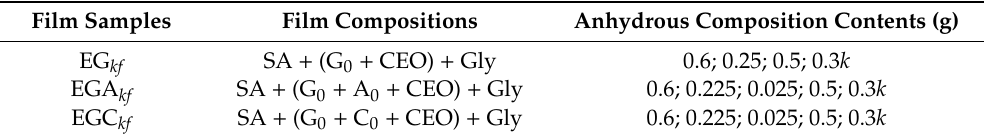
Table 1; secondly, after the films G, GA, and GC were obtained, each film was immersed in 25 mL of 2 wt% aqueous CaCl 2 solution for 30 s to be externally crosslinked and then dried at room temperature. Table 1. Formulation of the